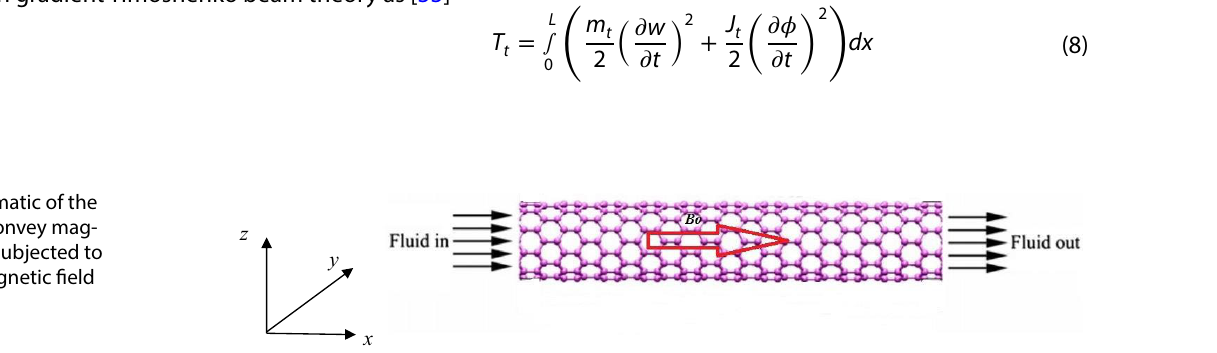
Fig. 1 The schematic of the SWCNT which convey mag- netic nanoflow subjected to longitudinal magnetic field